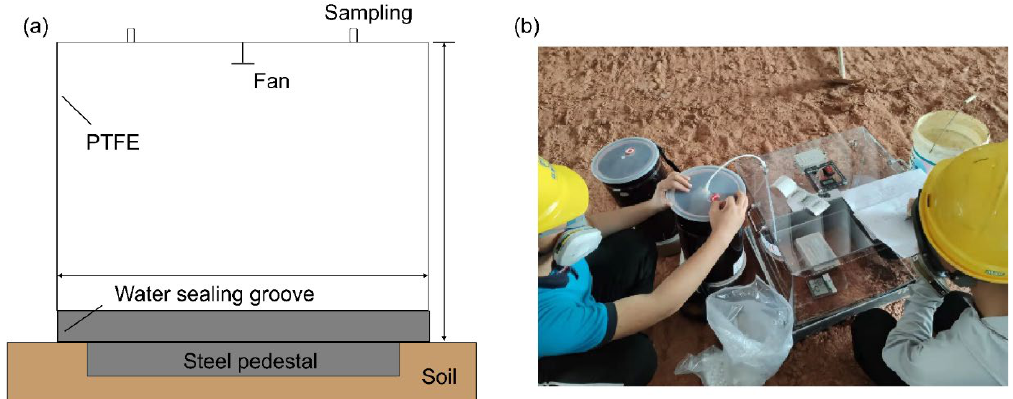
Figure 2. Collection of gas samples. ( a ) Schematic diagram of the flux chamber; ( b ) during gas sam- pling, the temperature, humidity, and pressure in the box were recorded using a hygrothermograph and pressure gauge. PTFE: polytetrafluoroethylene.